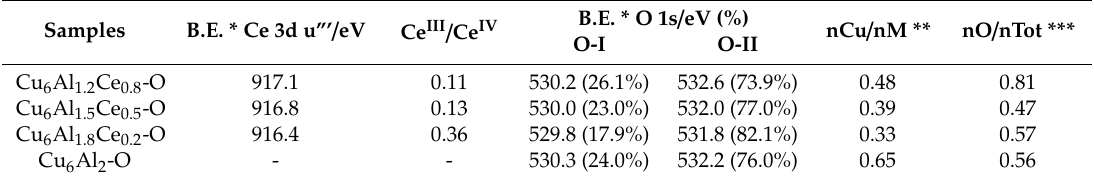
Table 3. Summarized XPS results from Ce 3d, O 1s spectra and atomic ratios.